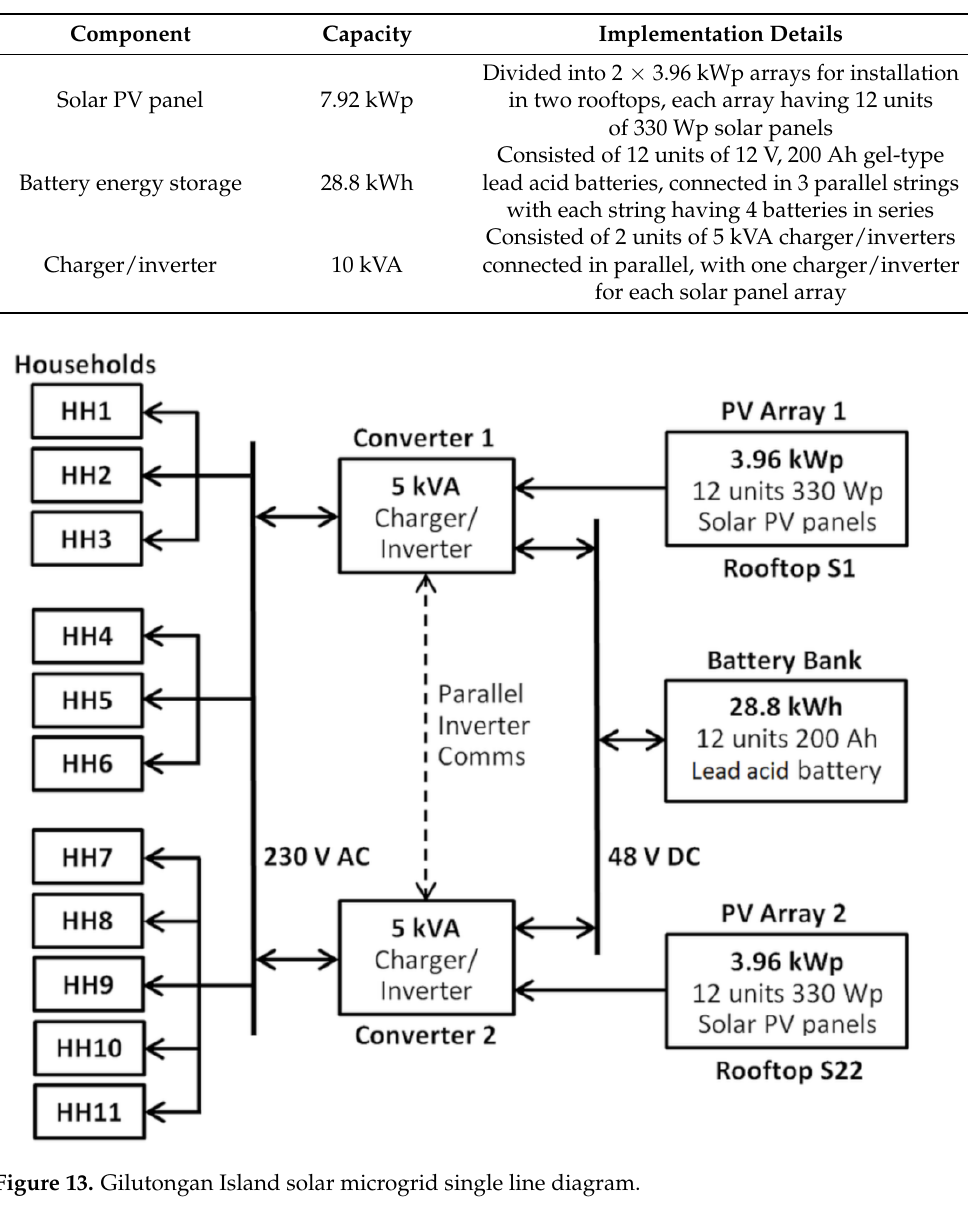
Table 9. Specifications for the main components of the Gilutongan Island rooftop solar microgrid as designed using HOMER Pro.